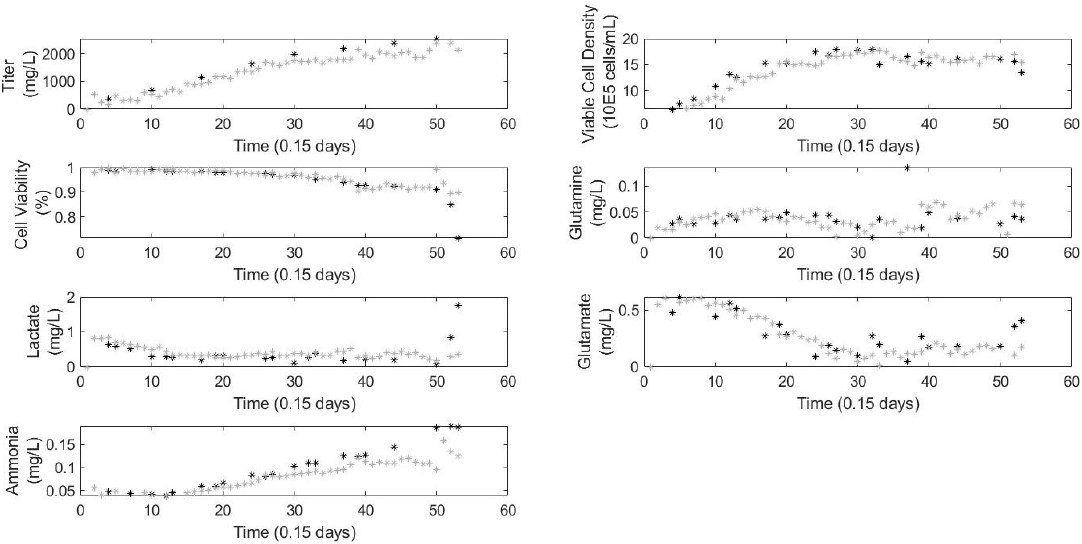
Figure 4. The training fit (grey) from the dynamic model for each output are compared against the process data (black) for a training batch.